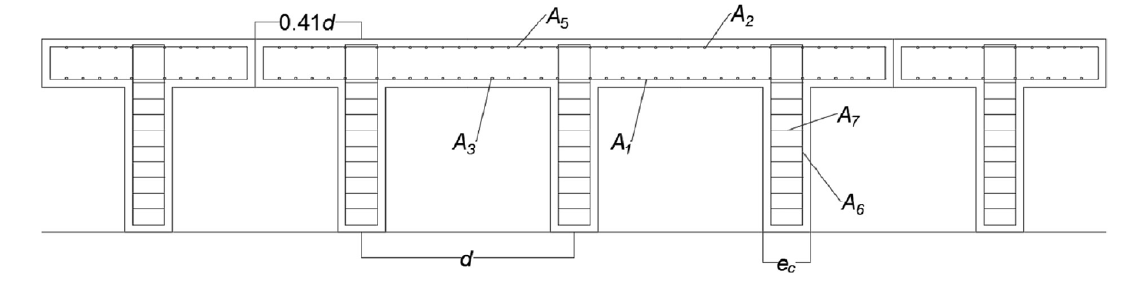
Figure 3. Earth-retaining buttressed wall. Floor cross-section [58].